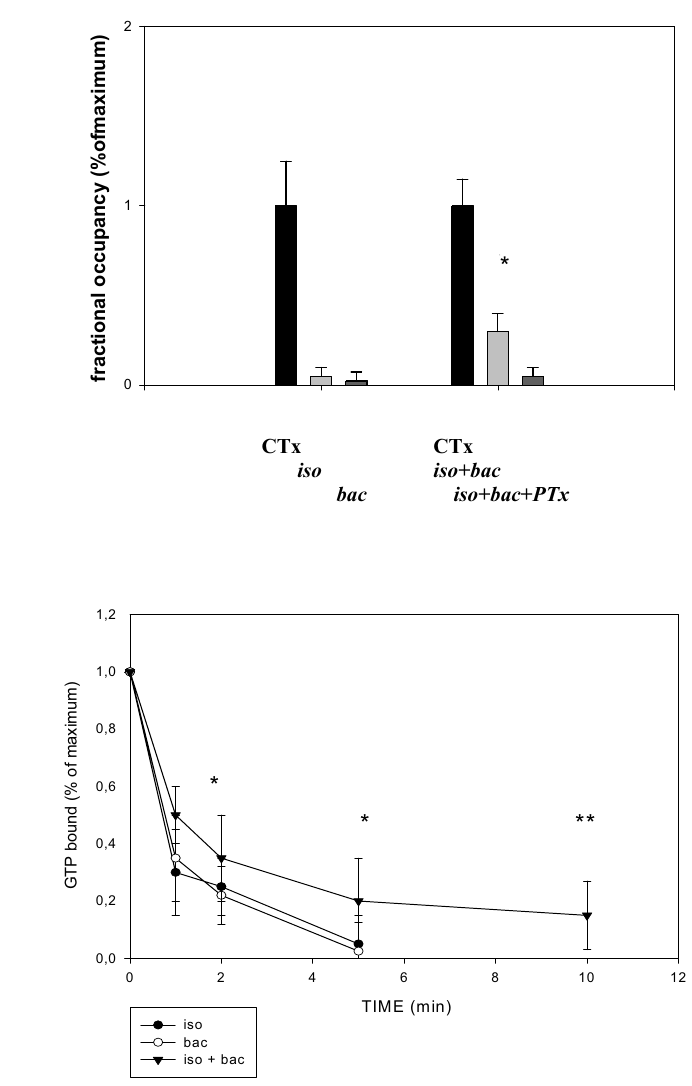
Figure 6 Determination of the fractional occupancy and hydrolysis of GTP in the catalytic site of G α s complexed with adenylyl cyclase(s) A: Fractional occupancy of GTP in cyclase(s) associated Gs . Comparative kinetics of GTP hydrolysis at 0°C. Membranes (50 µ g protein per assay) were incubated with [ γ 32 -P] GTP (1 µ M, 10 000 cpm/pmol) and isopro- terenol , isoproterenol + baclofen or baclofen (each 200 nM) in the presence of EDTA (1 mM) for 20 min at 20°C. The samples were placed on ice and complemented with Mg (5 mM) and an excess of cold GTP (1 mM) for 10 min, then the membranes were solubilized in presence of NaF (100 µ M) and a 'pull down' experiment using Forskolin-agarose was carried out as above. The radioactivity in the isolated 'pull down' was measured by filtration on nitrocellulose membranes and recorded as a per- centage (+/-SE) of the radioactivity measured in parallel experiment using membranes treated with cholera toxin ( CTx ). Bars represent the mean +/-SE of 5 experiments. * represents values of iso + bac significantly different from iso or bac (P < 0.01) B: Single turnover GTP hydrolysis of cyclase(s) associated Gs at 0°C. Membranes (50 µ g protein per assay) were incu- bated with iso , iso + bac or bac (each 200 nM) and with [ γ 32-P] GTP (1 µ M, 10 000 cpm/pmol) and EDTA (1 mM) for 20 min at 20°C. The GTPase reaction was initiated by the addition of MgCl2 (5 mM) and an excess of cold GTP (1 mM) in ice. At various time points, NaF (100 µ M) was added and membranes were immediately solubilized and incubated with Forskolin-agarose. Radioactivity in the 'pull down' complex attached to the Forskolin-agarose was counted as above and reported as percentage of the radioactivity at t = 0* P < 0.05 and ** P <